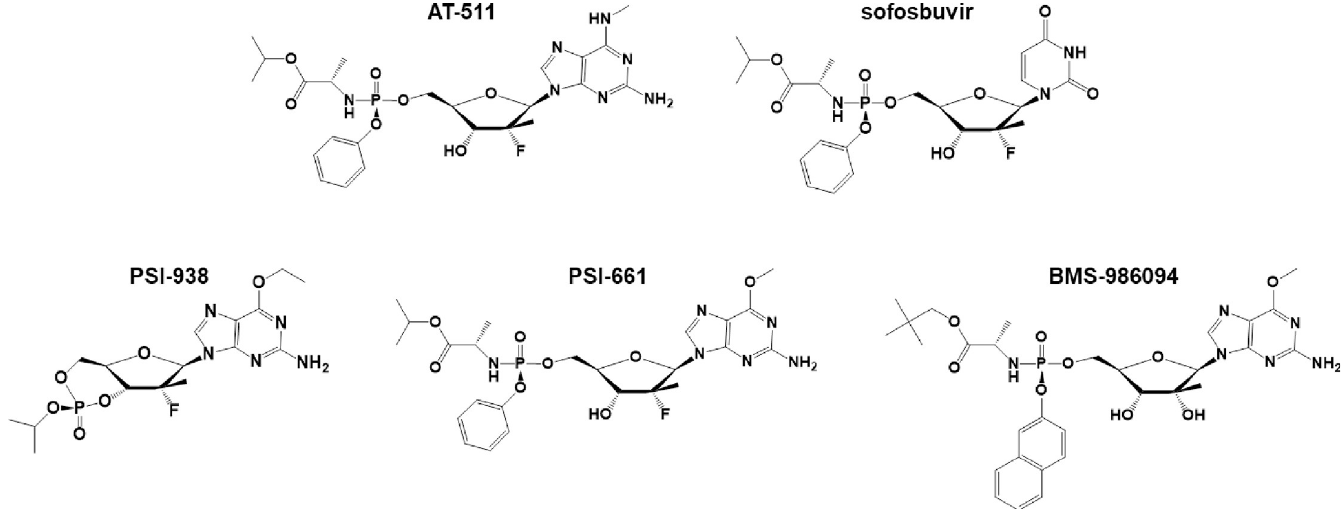
Fig 1. Chemical structures of AT-511, sofosbuvir (SOF), PSI-938, PSI-661 and